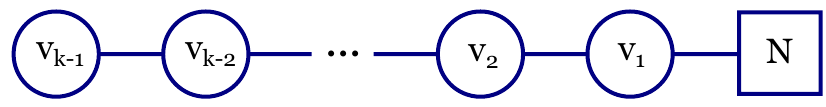
Figure 3 . Quiver of the T % [SU( N )] theory. The relation of ranks to % = ( n i ) is: v k − 1 = n k , v i = v i +1 + n i +1 [3,